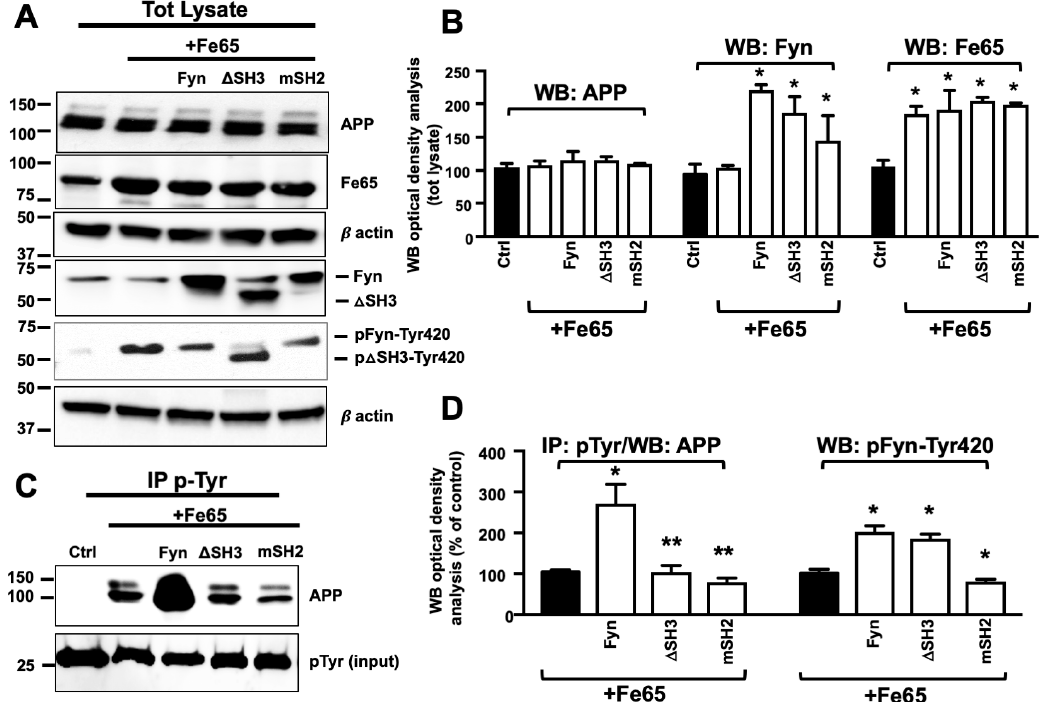
Figure 3. SH2 and SH3 motifs were crucial for Fyn-mediated APP phosphorylation at Tyr in Fe65-transfected neurons. ( A ) WB analysis of APP, Fyn, pFyn-Tyr420, and Fe65 proteins in total lysates from neural stem cells that were transfected with Fe65 with and without Fyn ∆ SH3, and Fyn mSH2. The densitometric analysis of APP, Fyn, and Fe65 expression before and after transfection is reported in ( B ). Densitometric analysis of pFyn-Tyr420 is reported in ( D ) instead. The data were normalized to β -actin values and are expressed as a percentage of control (Ctrl, empty vector). n = 3. * p < 0.05, vs. Ctrl. ( C ) Samples were immunoprecipitated with mouse anti-pTyr magnetic beads and analyzed by WB using the rabbit anti-APP antibody. The optical density analysis is reported in ( D ). Values were calculated by dividing pAPP-Tyr or pFyn-Tyr optical density values by the corresponding APP or Fyn values in total lysates, respectively. * p ≤ 0.05, vs. Fe65; ** p ≤ 0.05, vs. Fe65 + Fyn. n = 3. Statistically significant di ff erences were calculated using one-way ANOVA followed by Dunnett’s post hoc test.